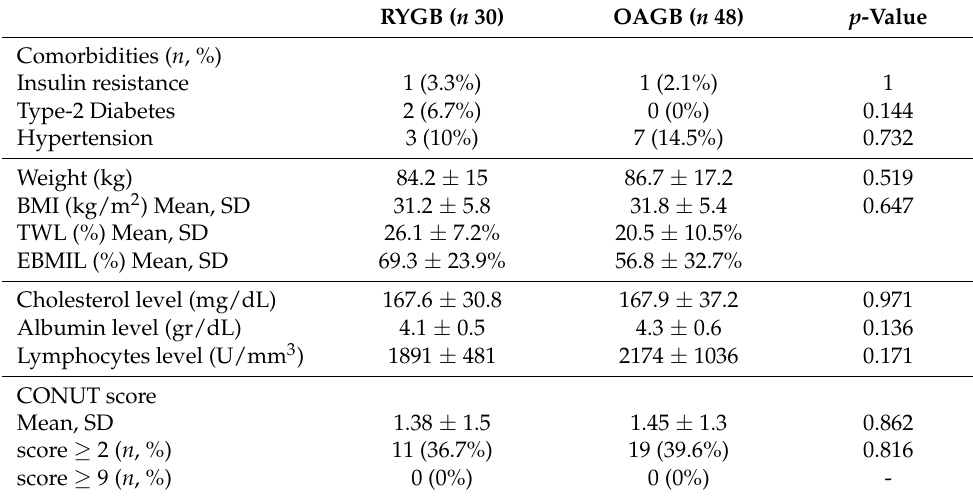
Table 4. Post-operative data at 6-Month Follow-Up: RYGB vs. OAGB. RYGB ( n 30) OAGB ( n 48)